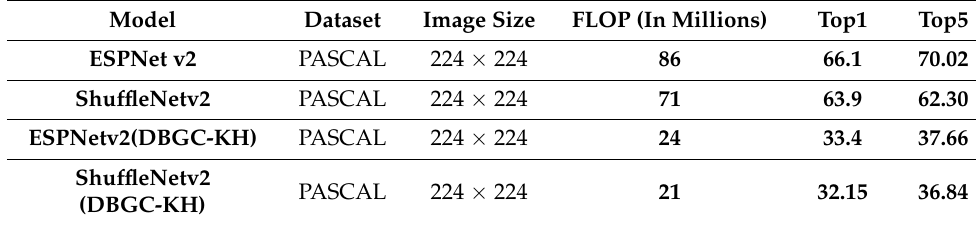
Table 4. Only height-based kernel.